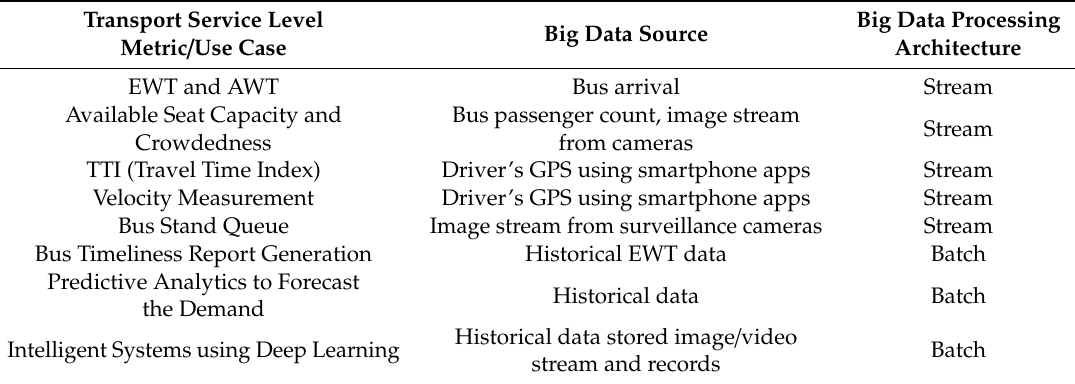
Table 2. Mapping of key transport service requirements and big data processing architecture.